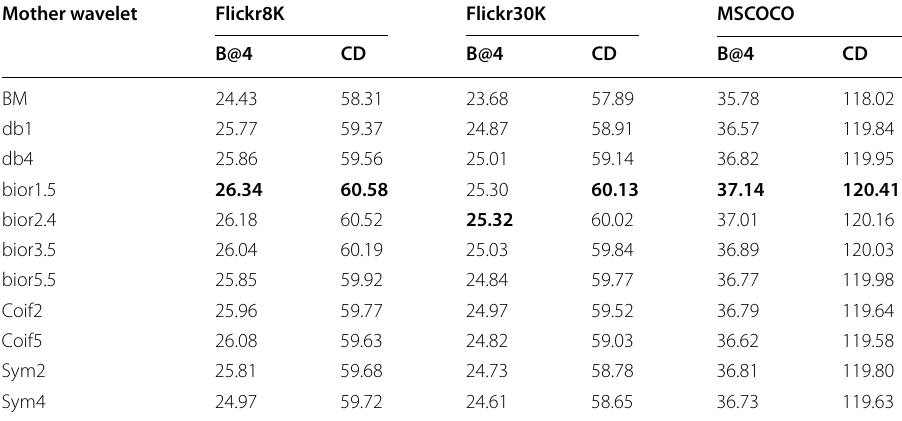
The highest values for each of the metrics are given in bold